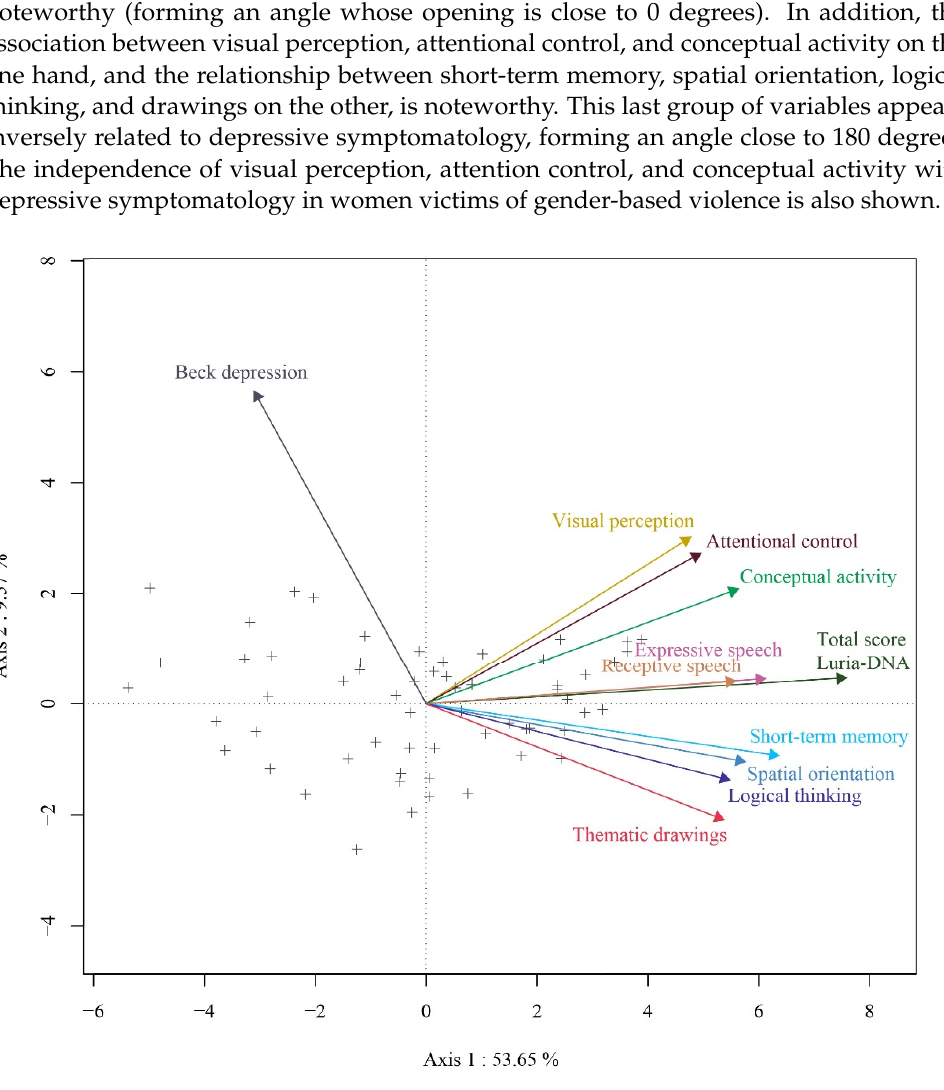
Figure 1. 2D graph of HJ-Biplot factorial axis 1–2.